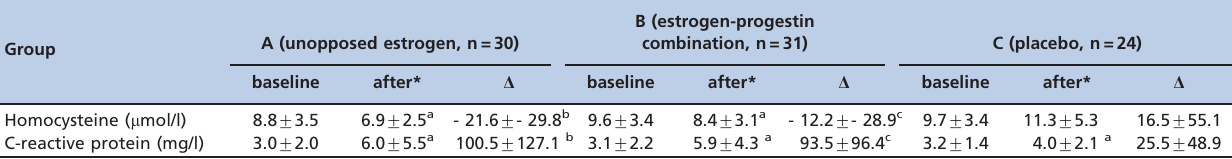
Table 2 - Homocysteine ( m mol/l) and C-reactive protein (ng/l) levels of the participants during the study. Group A (unopposed estrogen, n=30)